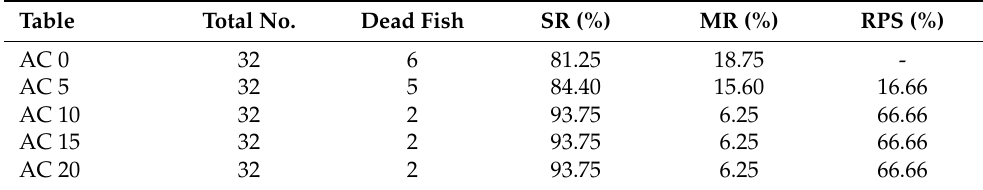
Table 5. Relative percentage survival and mortality rate (%) of Nile tilapia fed diets supplemented with graded, activated charcoal (AC) levels for 8 weeks and then exposed to a sub-lethal level of imidacloprid (IMID) for 2 weeks (Experiment II).